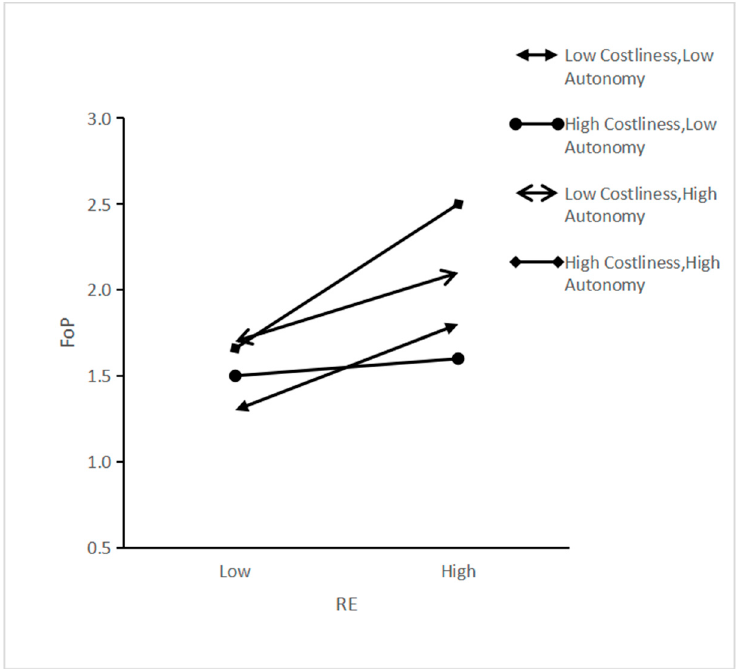
Figure 3. Three-way interaction of recycling effort, costliness and